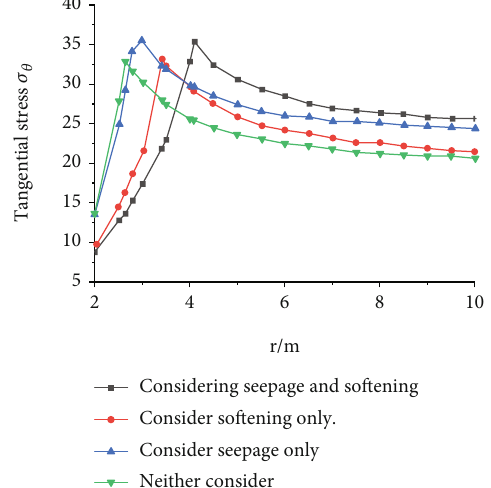
Figure 7: Tangential stress distribution of surrounding rock in 4 = 0 ). cases ( P 0 = 2MPa , b = 0 0 and R p in 4 cases ( b